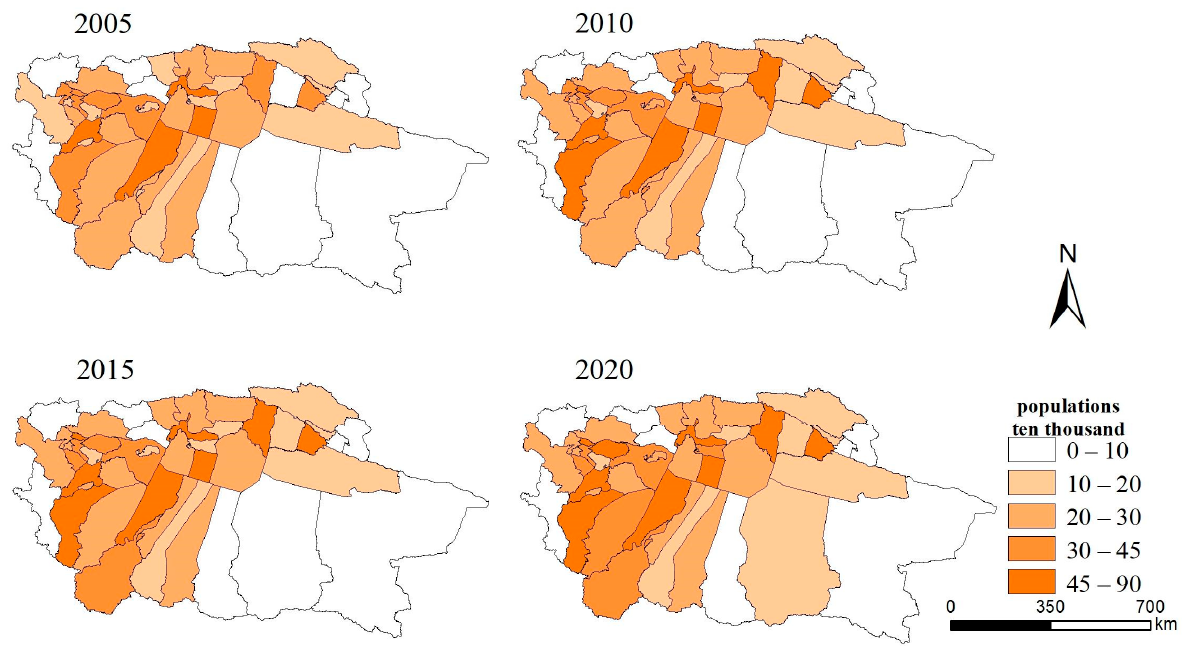
Figure 6. Spatial distribution of county and city populations in the Tarim River Basin.